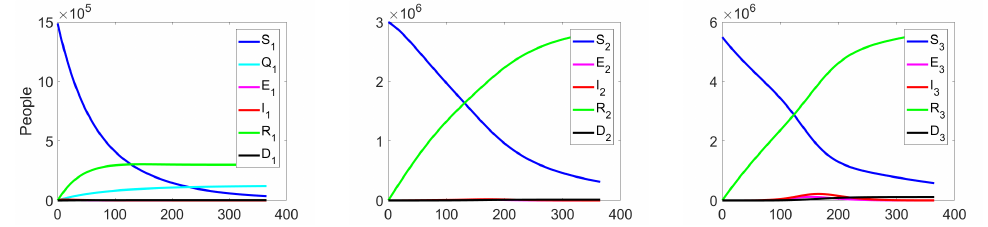
Figure 10. Experiment 2. Spread of the virus in three different clusters in the controlled case.